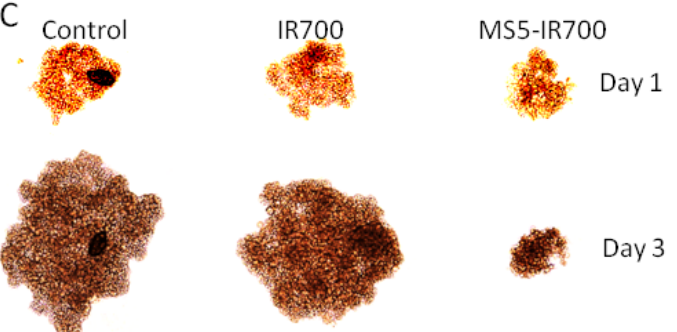
Figure 7. MS5-IR700 conjugate killed PC3 spheroids. ( A ) Spheroid around 200 µ m diameters were incubated with the conjugate 10 µ g/mL for 6 h at 37 ◦ C and then irradiated at the light dose of 60 J/cm 2 at a power density of 17 mW/cm 2 . After overnight incubation at 37 ◦ C, the live/dead cells were visualized by incubation with FDA and PI. ( B ) Spheroid growth after NIR irradiation. Spheroids (around 350 µ m in diameter) were incubated or not with the MS5-IR700 conjugate as in ( A ). A control group received IR700 (100 nM). After NIR exposure, spheroid diameters (3–4 spheroids/group) were measured every day up to 5 days. For illustration, light images of the spheroids on days 1 and 3 post-NIR irradiation are shown ( C ). The data are representative of 4 independent experiments. * p < 0.05, ** p < 0.01, *** p < 0.001, **** p < 0.0001.